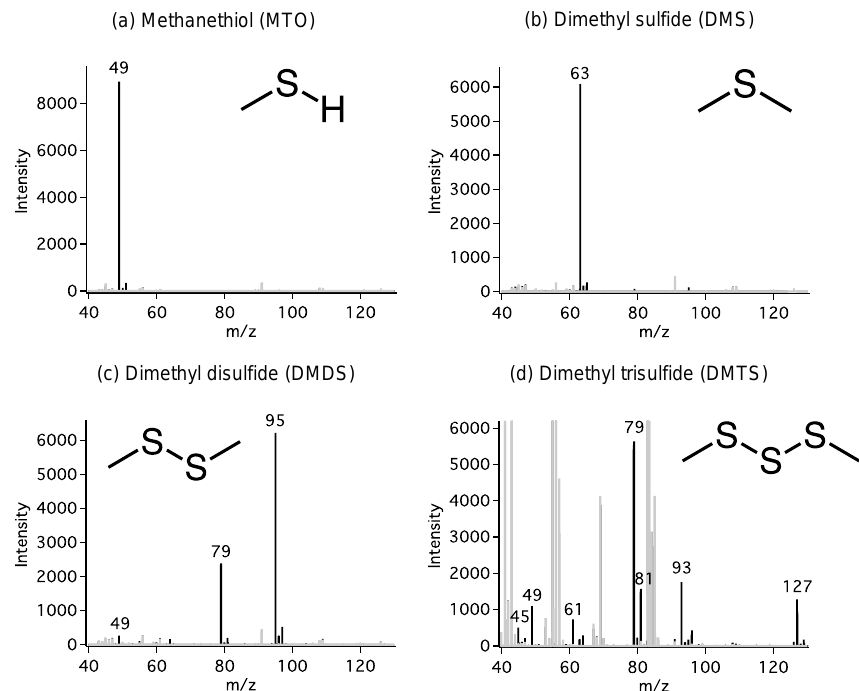
Figure 1. Individual PTR-ToF-MS mass spectra for each organosulfur compound: (a) methanethiol (MTO) from the laboratory-generated gas-phase standard, (b) dimethyl sulfide (DMS) and (c) dimethyl disulfide (DMDS) from injection of the individual pure liquid standards into air in a 100L Teflon chamber, and (d) dimethyl trisulfide (DMTS) from the dynamic injection system. In spectra (b) and (c) , the gray peaks correspond to ion fragments resulting from the ionization of background species in the Teflon chamber; in (d) , the gray peaks correspond to ion fragments resulting from the ionization of cyclohexane, which is used here as the solvent. Table 1. Accurate mass and elemental composition of the major fragments observed for the analysis of standard organosulfur compounds by PTR-ToF-MS. Accurate Intensity Elemental Exact Absolute mass mass (Da) (%) composition mass